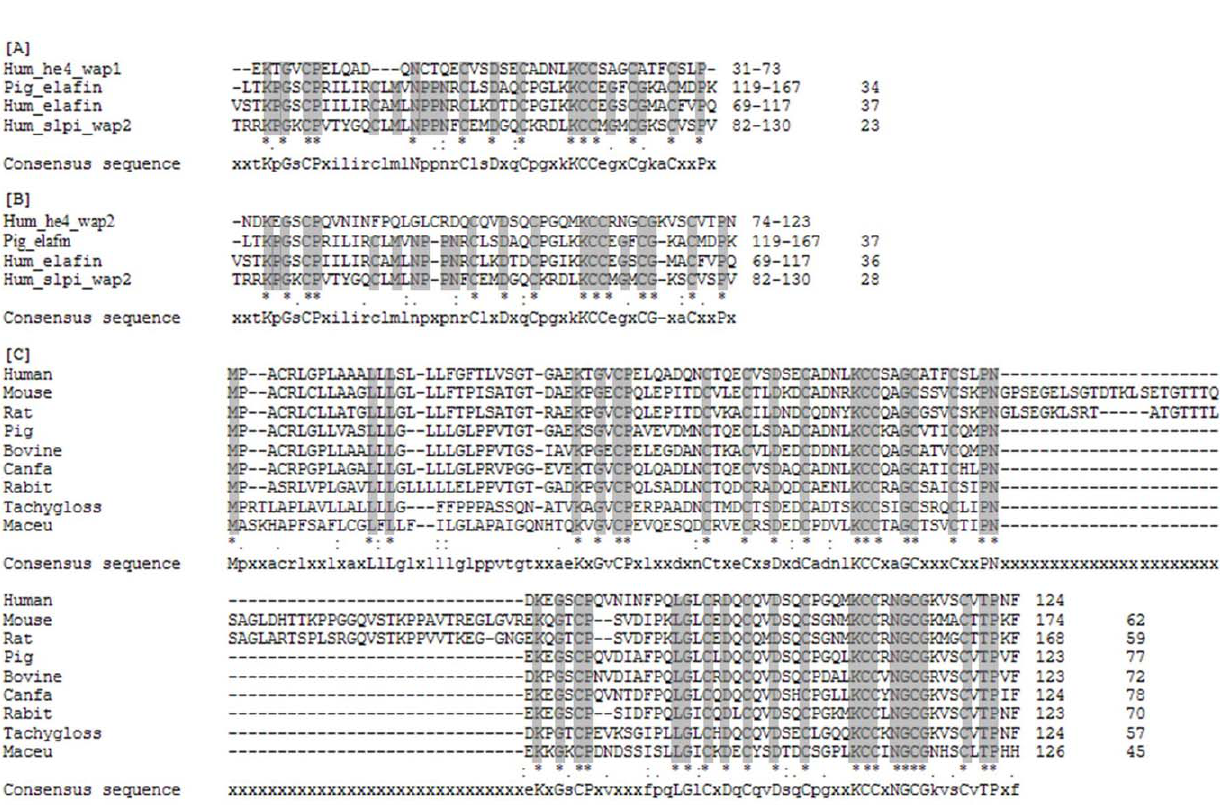
Figure 3. Multiple sequence alignment of HE-4 with other WAP protein and HE-4 of different species. At the end of each line of amino acid sequence, amino acid residue numbers are given and after that % homology is written. ( A ) Sequence alignment of HE-4 WAP 1 domain with other antiproteases like elafin and WAP-2 domain of SLPI. ( B ) Sequence alignment of HE-4 WAP2 domain with other antiproteases like elafin and SLPI. ( C ) Multiple sequence alignment of HE-4 protein of human with HE-4 protein of different